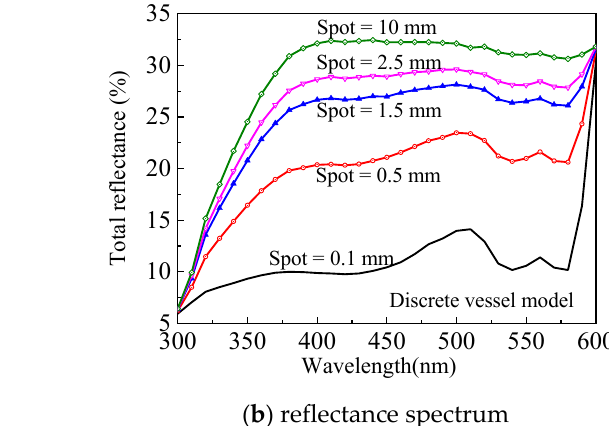
Figure 13. Light absorption induced by the blood vessel with different depths.